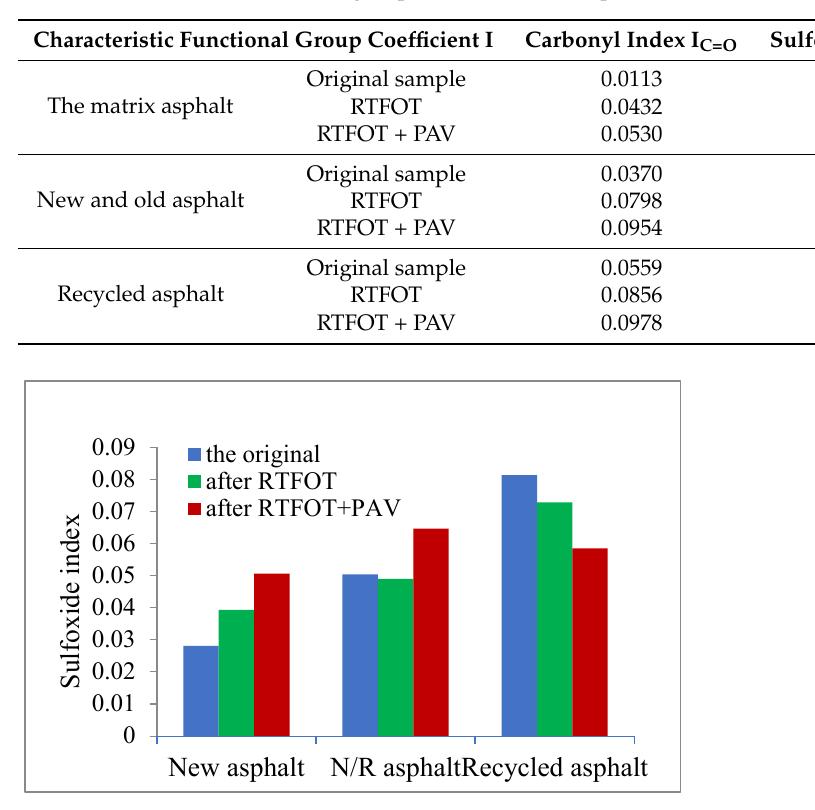
Table 4. Characteristic functional group indexes of three asphalts before and after aging.